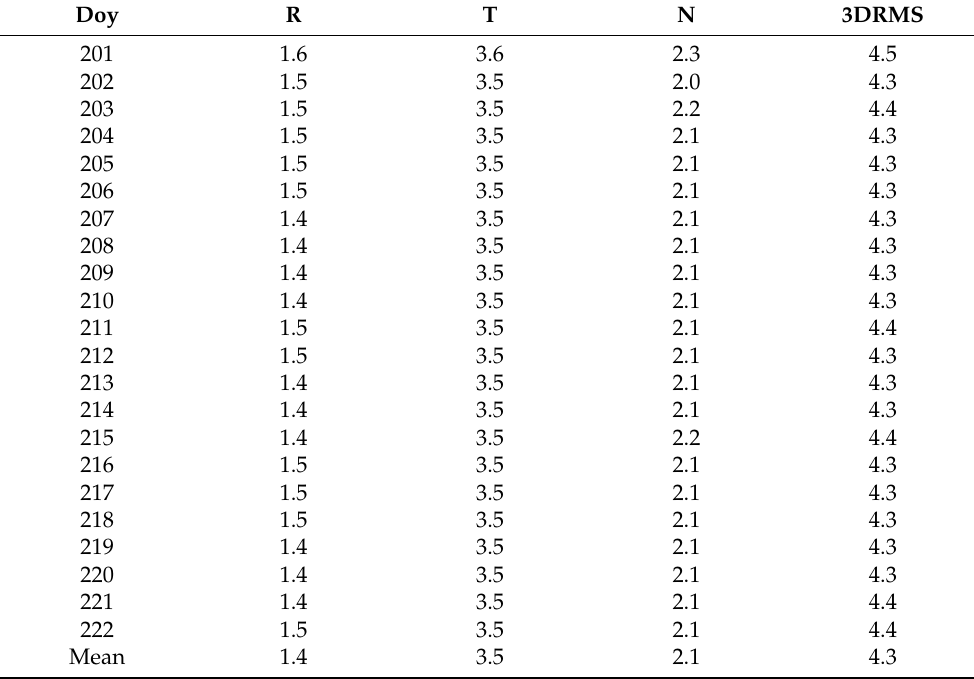
Table 7. The statistics of accuracy for HY2D satellite using spaceborne GPS data (unit: